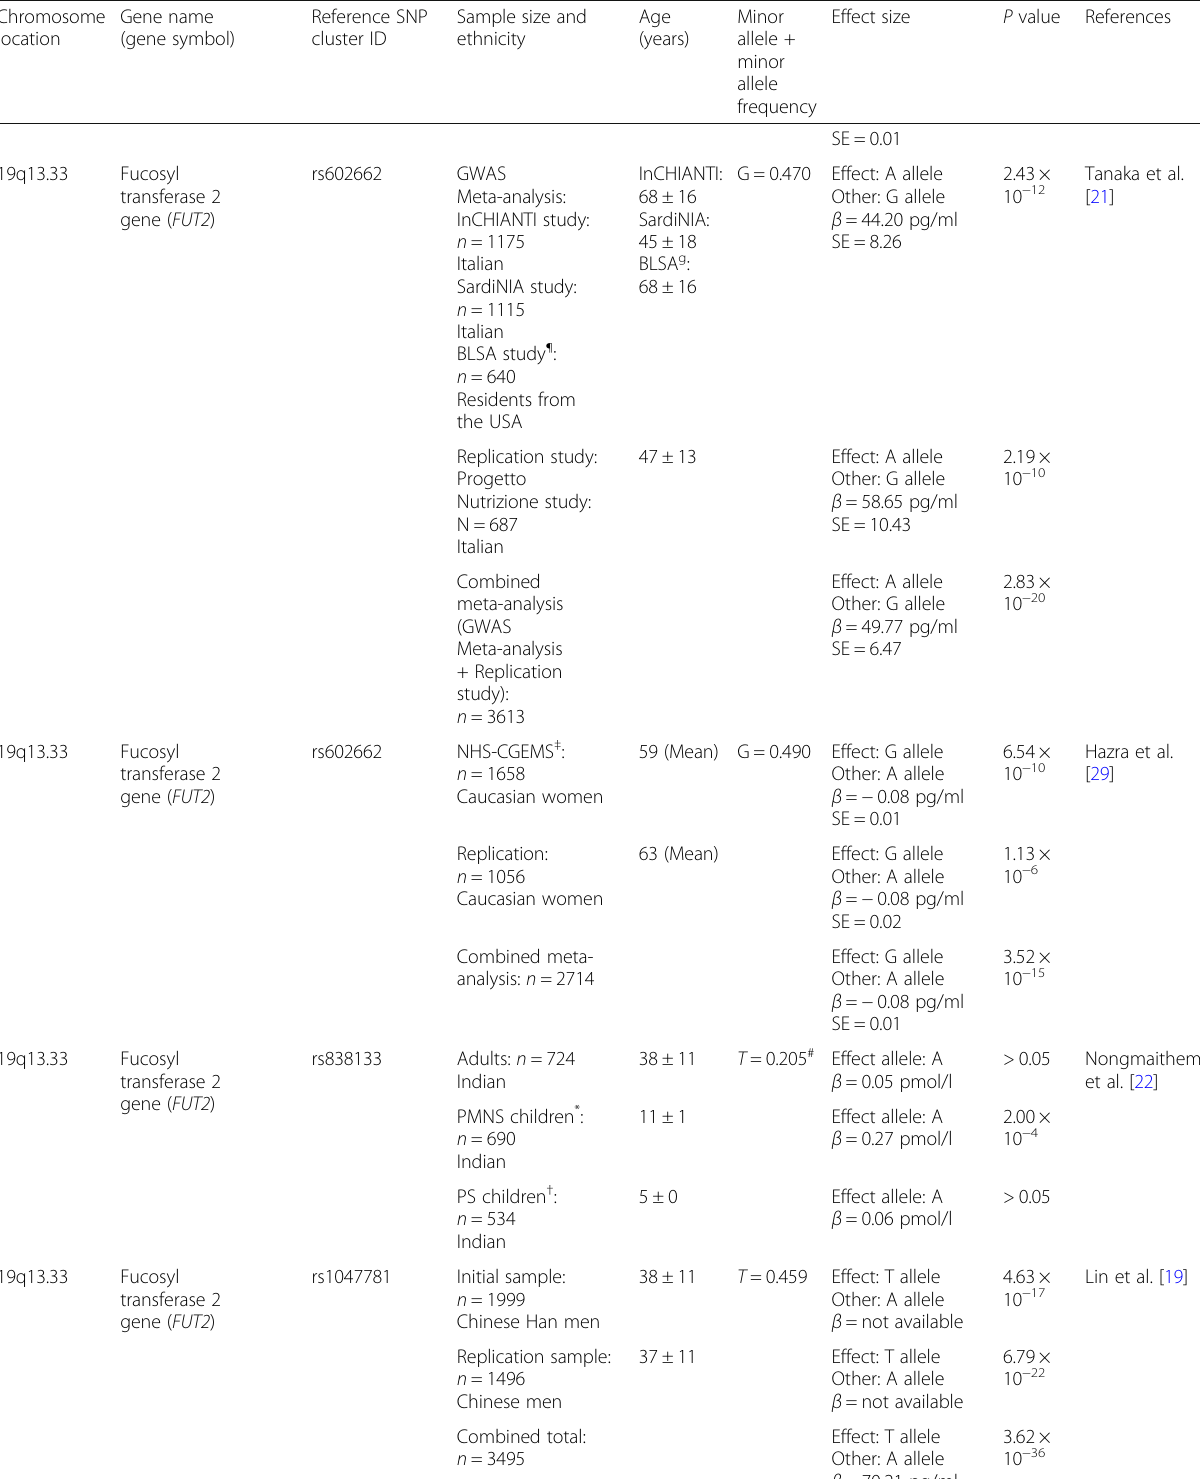
Table 1 Genome-wide association studies showing the association of SNPs with vitamin B12 concentrations. Genome-wide association studies testing the association between SNPs and vitamin B12 concentrations. The chromosome location, gene name, reference SNP cluster ID, sample size and ethnicity, mean age, observed frequency of the minor allele in the population, effect size and P value are shown in the table. The order of SNPs reflects the order of the chromosome location